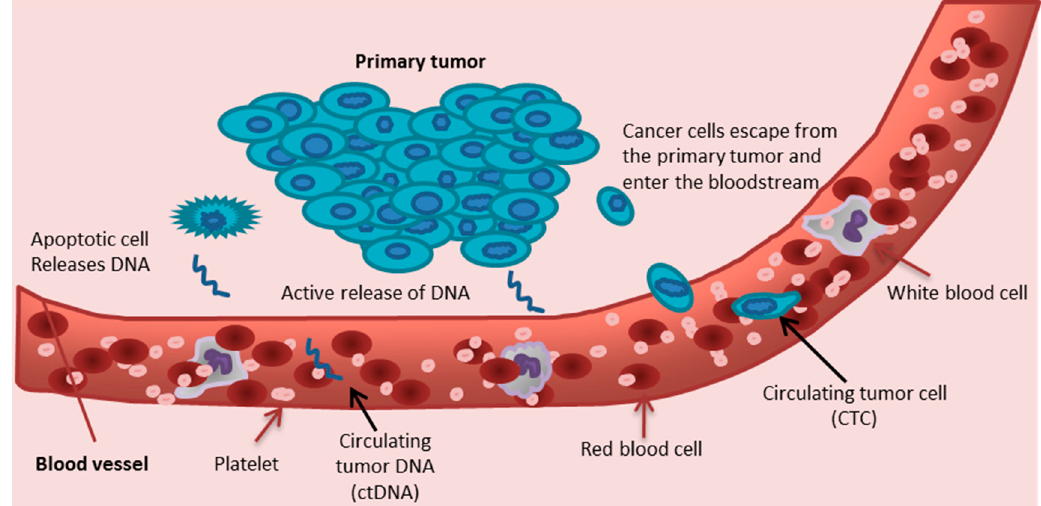
Figure 2. Different mechanisms that lead to the release of tumor cells and tumor DNA from the primary tumor into the blood stream. Circulating tumor cells (CTC) and circulating tumor DNA (ctDNA) can then be obtained by a normal blood draw.